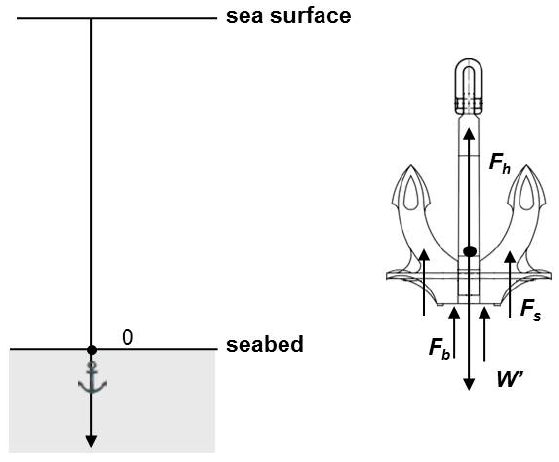
Figure 7. Force analysis of an anchor in soil.